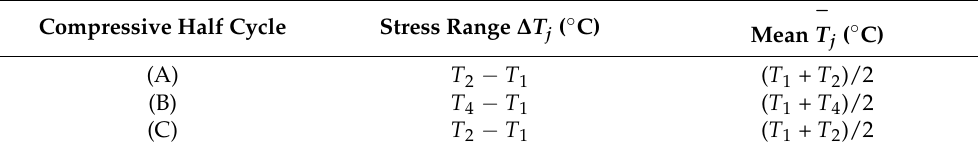
Table 10. Half-cycle counting for compressive valleys in a reduced thermal profile.